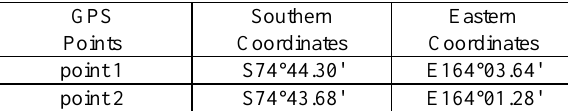
Table 2. GPS end points headwind runway